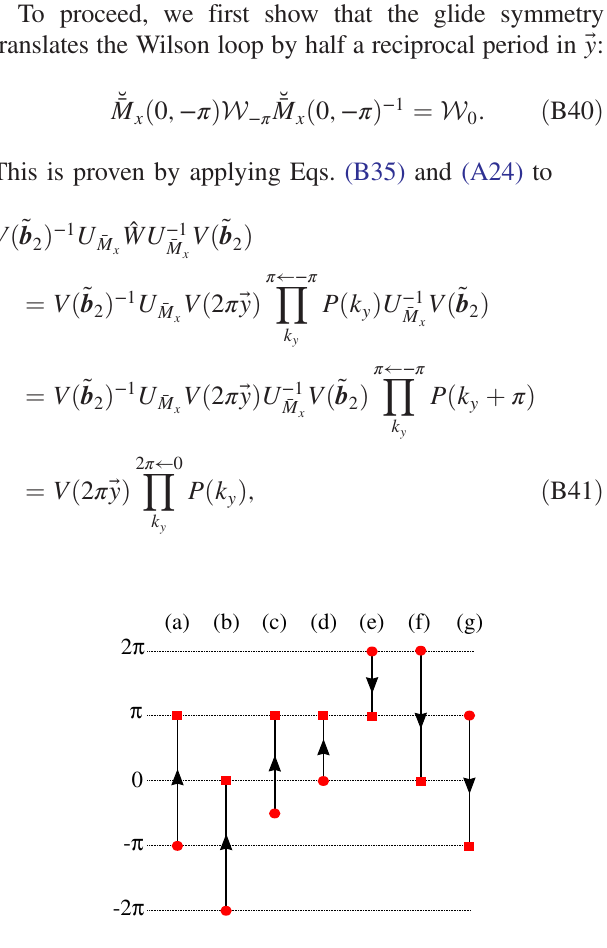
FIG. 12. To clarify our notations for Wilson loops and lines, we draw several examples, all of which occur at fixed k ∥ and variable k (vertical axis). The arrow indicates the orientation for parallel y transport. (a) The Wilson loop at base point − π (encircled) is labeled by W − π ≡ W π ← − π . (b) W − 2 π ≡ W 0 ← − 2 π . (c) W π ← − π ¯ k and oriented in the direction of decreasing k point y in (f) and W in r; π